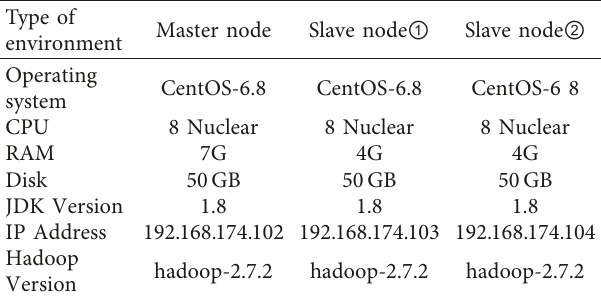
Figure 11: Inclination of tool rest guide rail to the left and right of workpiece. Table 1: Environment configuration information of each service node in the